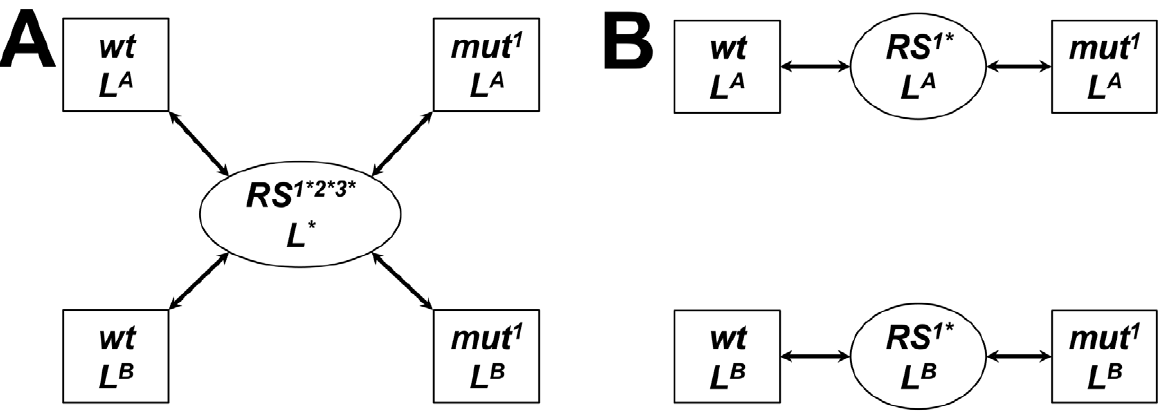
Figure 1. Alchemical thermodynamic paths using SRMM (A) and SRSM (B) in the bound state between wild type ( wt ) and a mutant ( mut 1 ). The paths (arrows) between end states (squares) going through nonphysical reference states (ovals) are shown. The SRMM uses a common reference state ‘hub’ for all mutations and ligands (RS 1*2*3* L * ); SRSM uses a mutation and ligand-specific reference state (RS 1* L X ). Decoupled residues and ligands are noted by an ‘*’. Thermodynamic paths in the unbound state have a similar form but without the